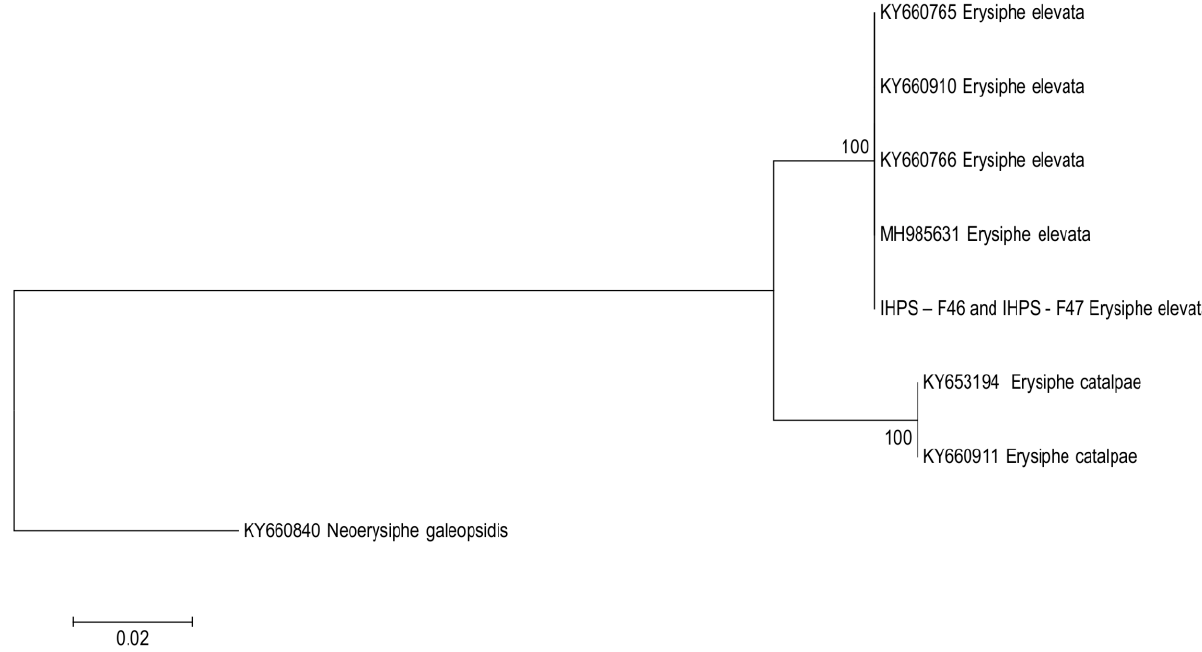
Figure 10. Neighbour-joining phylogenetic tree of Erysiphe elevata isolates IHPS-F46 and IHPS-F47, based on rDNA – ITS sequences. Numbers at the nodes indicate bootstrap values generated from 10,000 replicates. The scale bar indicates the number of nucleotide substitu-